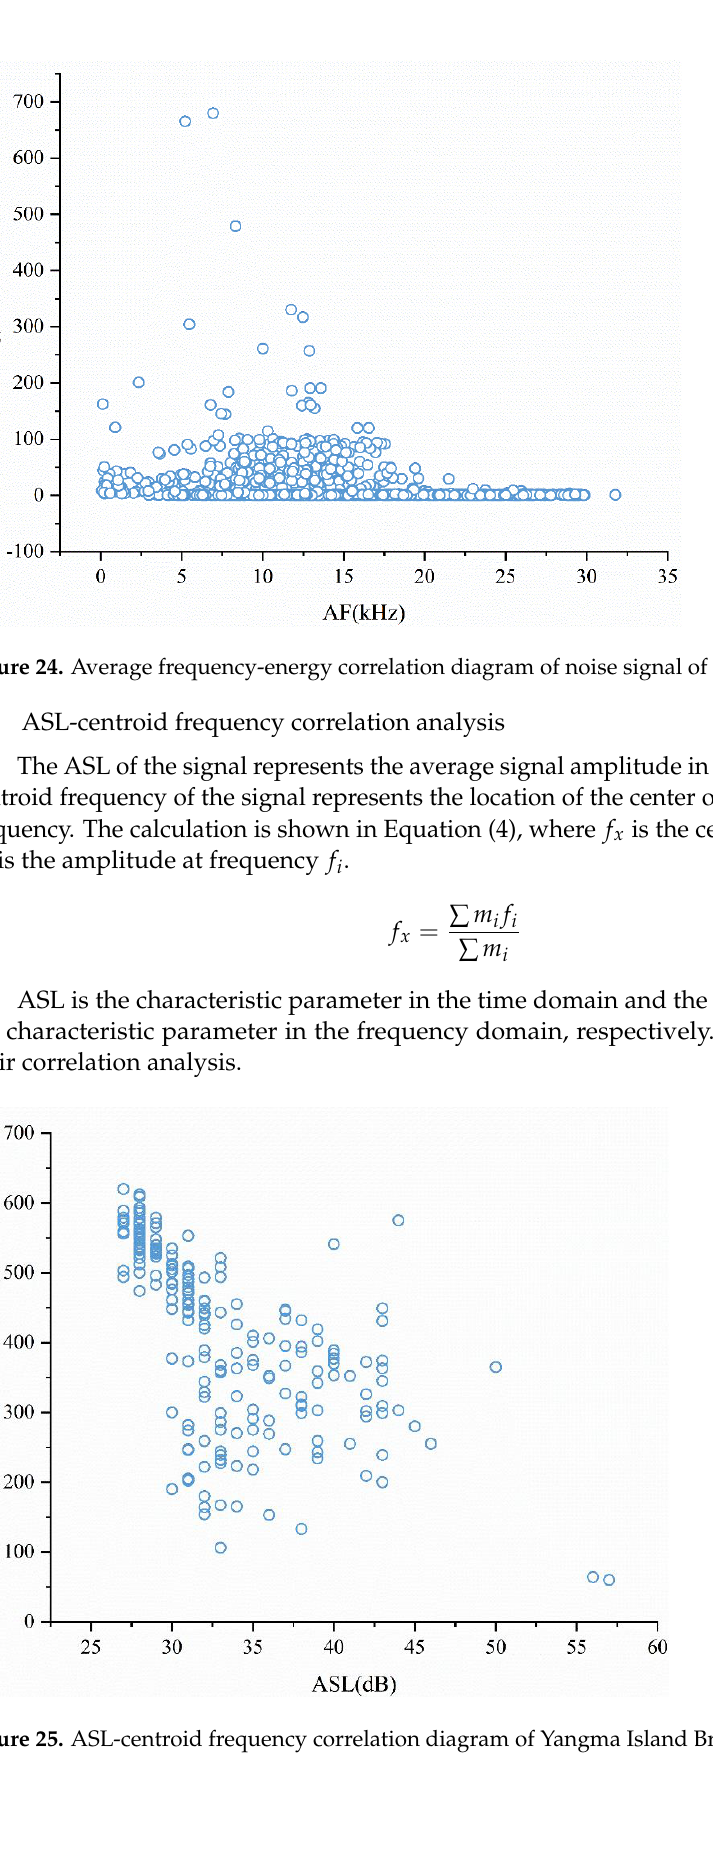
Figure 26. ASL-centroid frequency correlation diagram of Yellow River Bridge.